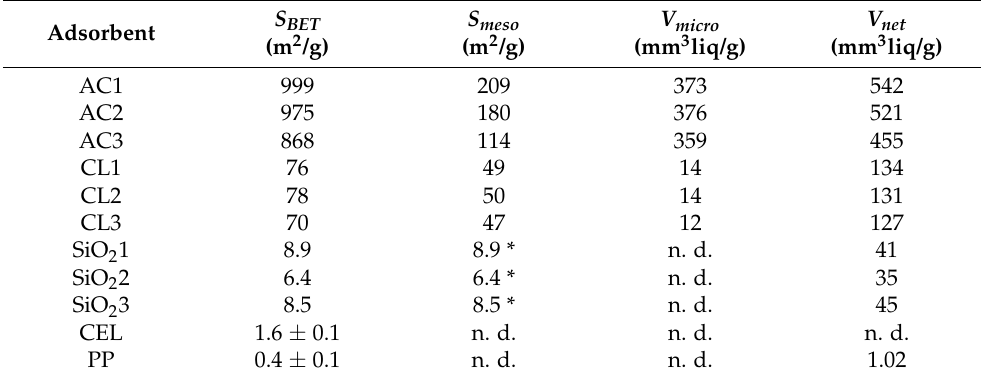
(Figure 6d inset) and broad mesopores/macropores of 47–50 m 2 /g surface area (Figure 6d). There are no differences between individual particle-size fractions of CL, the properties of individual particle-size fractions being identical. Table 2. Determined textural properties of